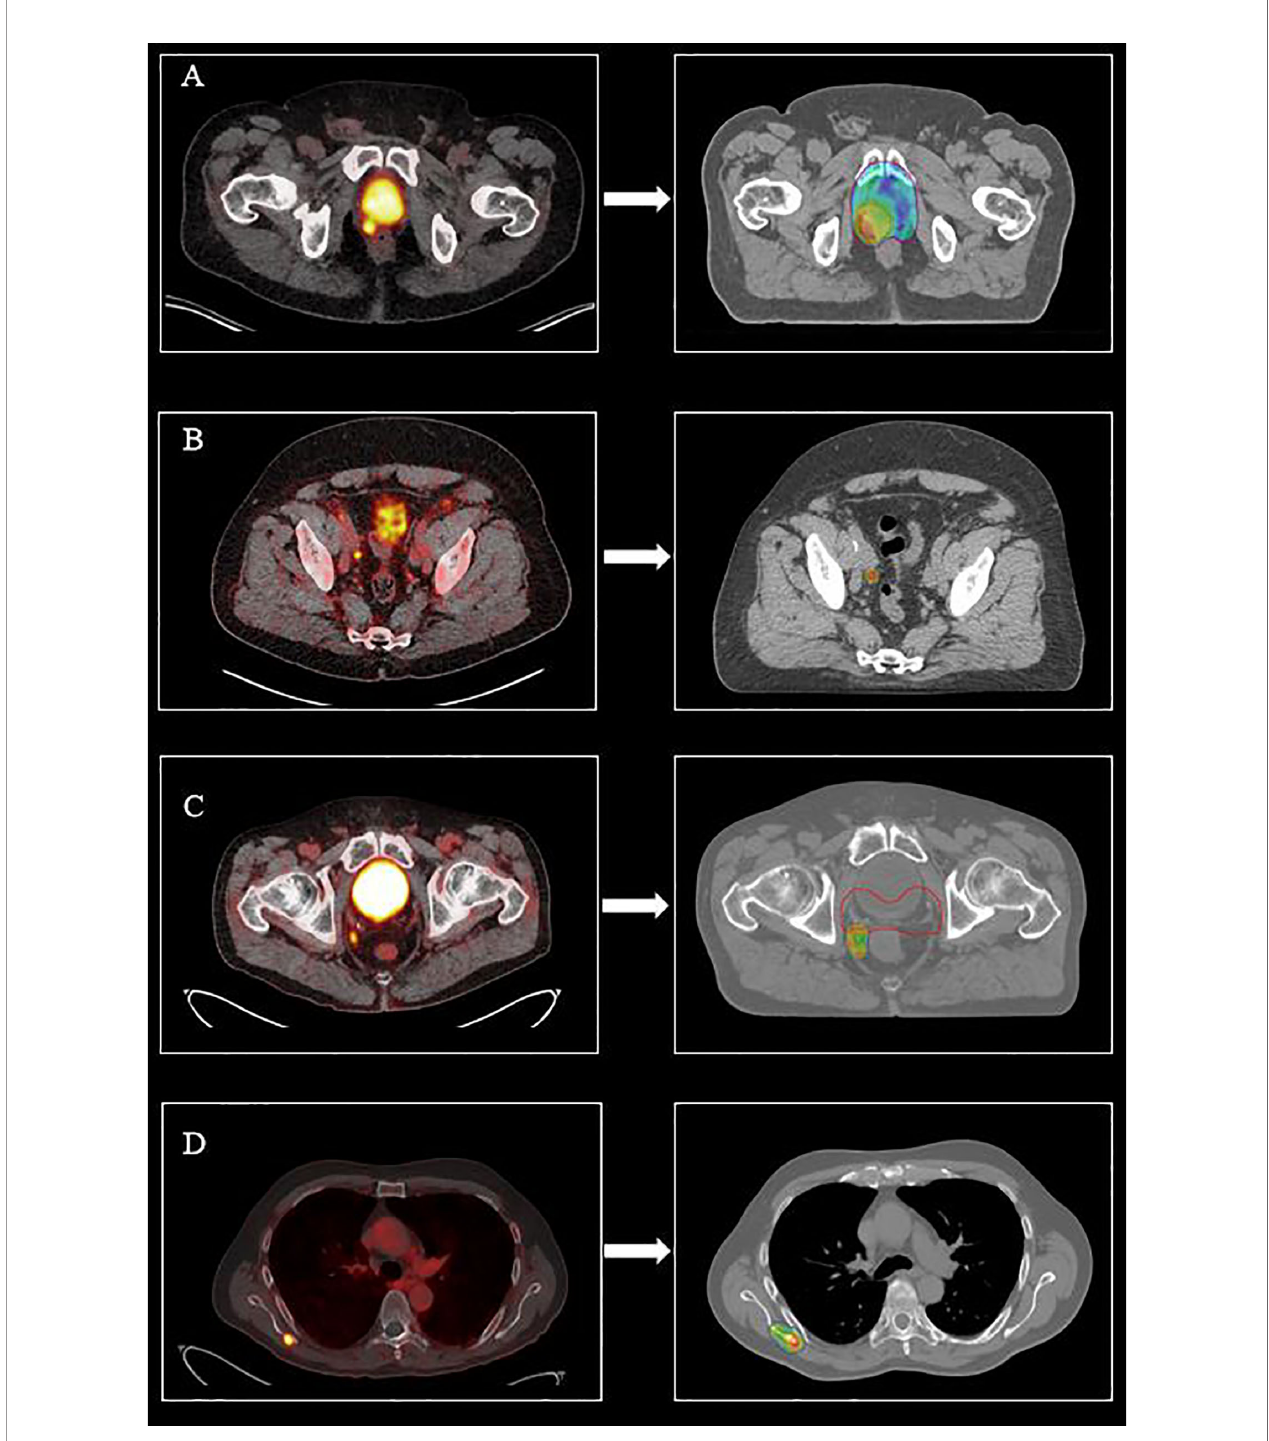
FIGURE 1 | 68 Ga-PSMA PET/CT restaging fi ndings and the corresponding salvage radiotherapy treatments (color wash isodose line 95%) in patients with biochemical recurrent prostate cancer after radical prostatectomy. (A) 68 Ga-PSMA PET/CT revealing a prostate bed recurrence located close to the bladder neck (left). Prostate bed radiotherapy (64 Gy/32 fx) planned with a simultaneous integrated boost (70.4 Gy/32 fx) (right) to the PET/CT positive lesion. (B) 68 Ga PSMA PET/CT revealing a millimetric solitary right external iliac node (left). Salvage stereotactic body radiation therapy planned on the PSMA avid node (30 Gy/3 fx) (right). (C) 68 Ga PSMA PET/CT revealing a perirectal oligorecurrent nodal relapse after radical prostatectomy and salvage prostate bed radiotherapy (left). Stereotactic body radiation therapy planned on the PSMA avid node (35 Gy/5 fx). Prostate bed PTV is shown in red (right). (D) 68 Ga PSMA PET/CT revealing an oligometastatic bone metastasis located at the right scapula (left). Stereotactic body radiation therapy planned to the PET/CT positive bone lesion (30 Gy/3 fx).